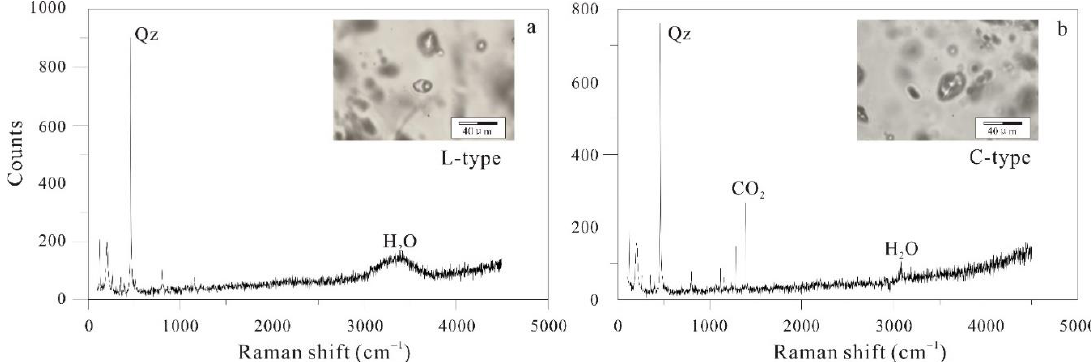
Figure 7. Representative Laser Raman spectra of fluid inclusions in the Toudaochuan deposit: ( a ) spectrum for C-type FIs and ( b ) spectrum for L-type FIs.